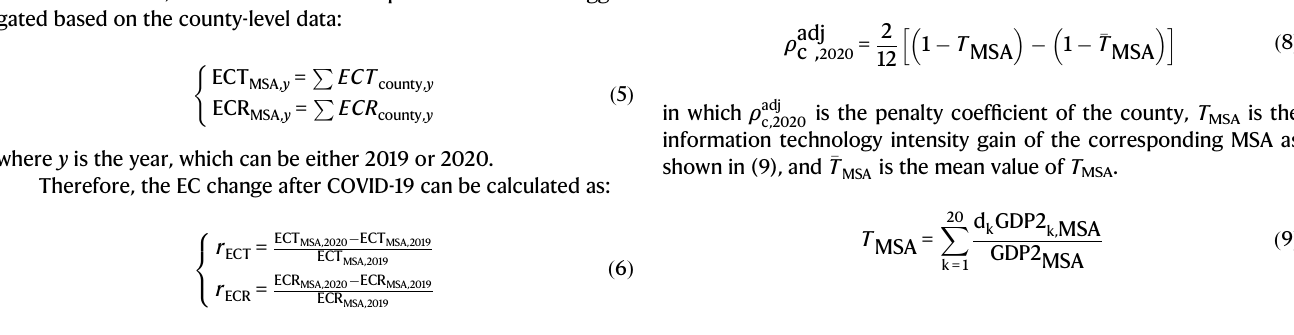
Fig. 7 | Data processing and computation fl ow. Green boxes denote the source data, yellow boxes denote preprocessed data, and orange boxes denote the computed results. The source data can be found in the reference, and a copy of